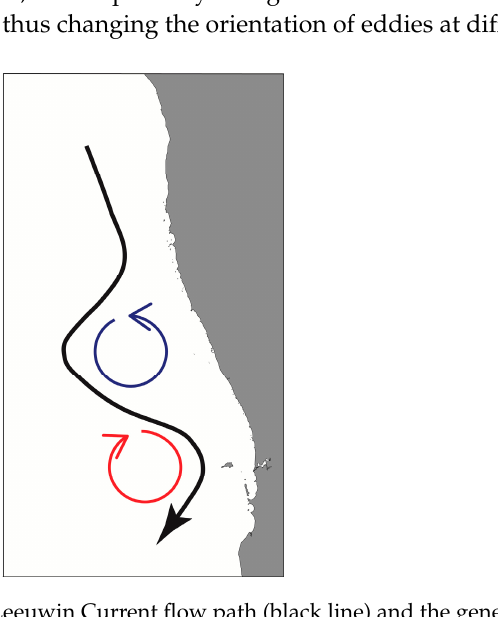
Figure 14. Schematic of the typical Leeuwin Current flow path (black line) and the generation of CCW (blue) and CW (red) vorticity and thus sub-mesoscale eddies.